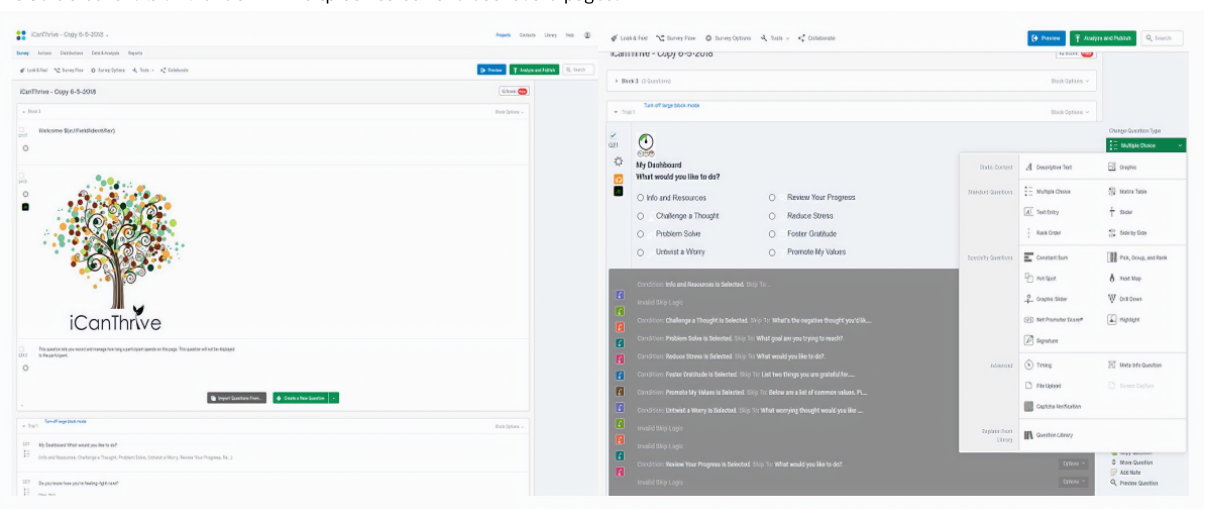
Figure 3. Screenshots of the iCanThrive splash screen and dashboard